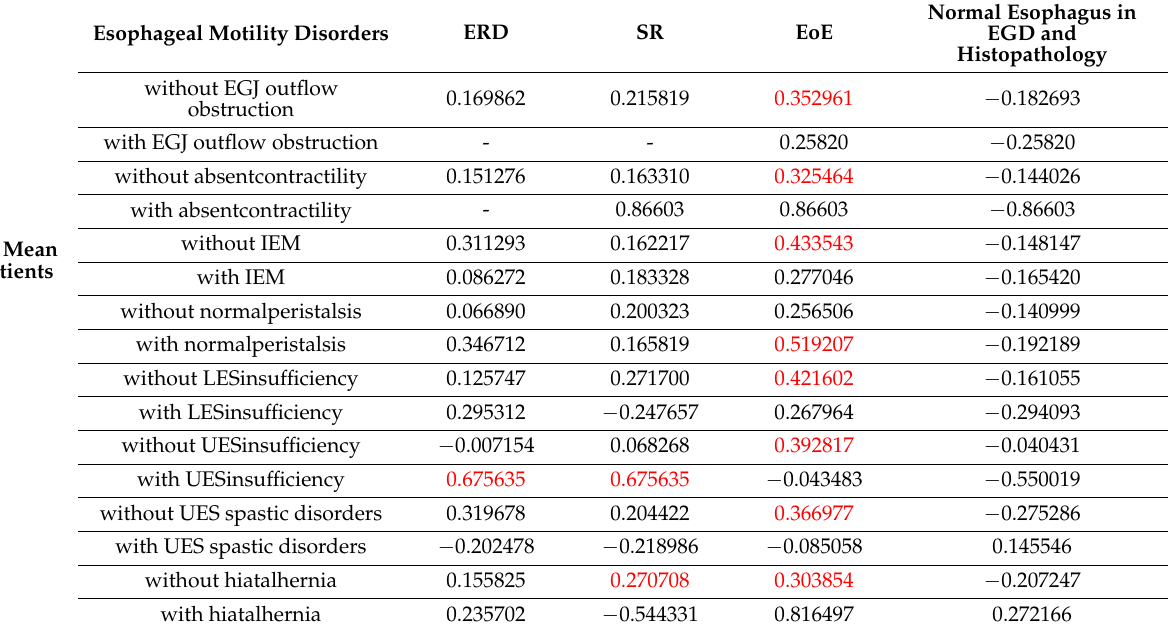
Table 6. Spearman’s rank correlation coefficients between diagnosis of ERD, SR, EoE, normal esophagus and total GIQLI mean points in patients with or without esophageal motility disorders. Significant—in red.